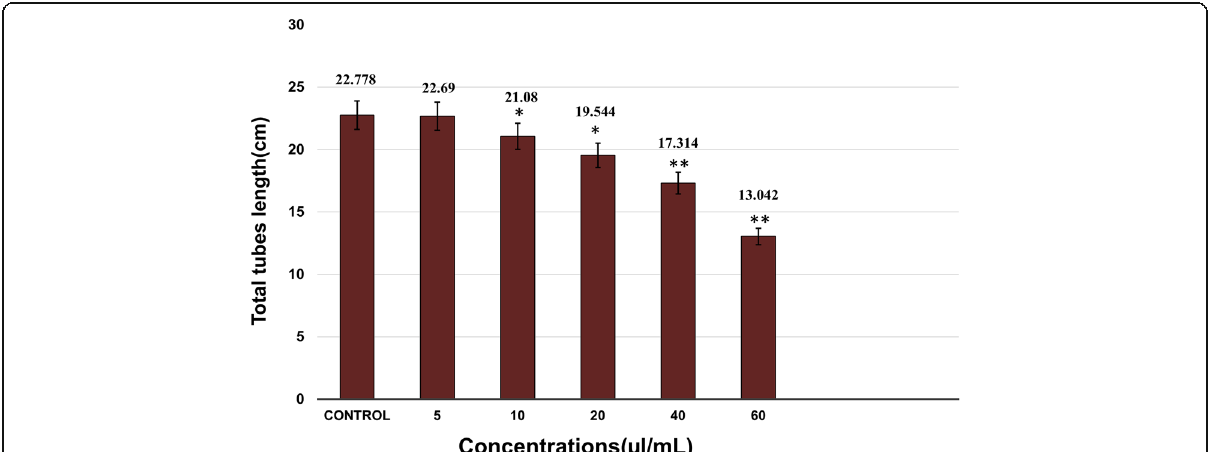
Fig. 3 Inhibitory effects of crude microcystins on HUVECS tubular structures formation at various concentrations (5 – 60 μ l/mL). Total tubes lengths of HUVECs on Matrigel in the presence of various concentrations of microcystins. Data are expressed as means of values ± SEM. * p < 0.05 and ** p < 0.01 as compared to control